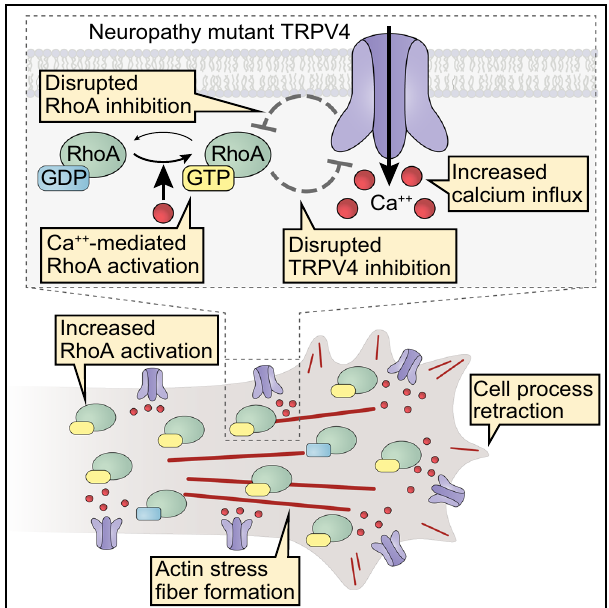
Fig. 7 Neuropathy mutations cause multifaceted disruption of TRPV4 – RhoA interactions. Schematic representation of how TRPV4 neuropathy mutations disrupt normal TRPV4 – RhoA functional interactions. TRPV4 binding to RhoA (Fig. 1) is disrupted by TRPV4 neuropathy mutations (Figs. 2 and 3). Impaired binding causes loss of TRPV4-mediated RhoA inhibition (Fig. 4) and disruption of RhoA-dependent TRPV4 ion channel inhibition (Fig. 4). Excessive calcium in fl ux via neuropathy mutant TRPV4 causes further activation of RhoA (Fig. 5). Together, disrupted TRPV4 – RhoA interactions lead to increased TRPV4 ion channel activity, increased RhoA activation, RhoA-mediated actomyosin contraction, actin stress fi ber formation, and cell process retraction (Figs. 5 and